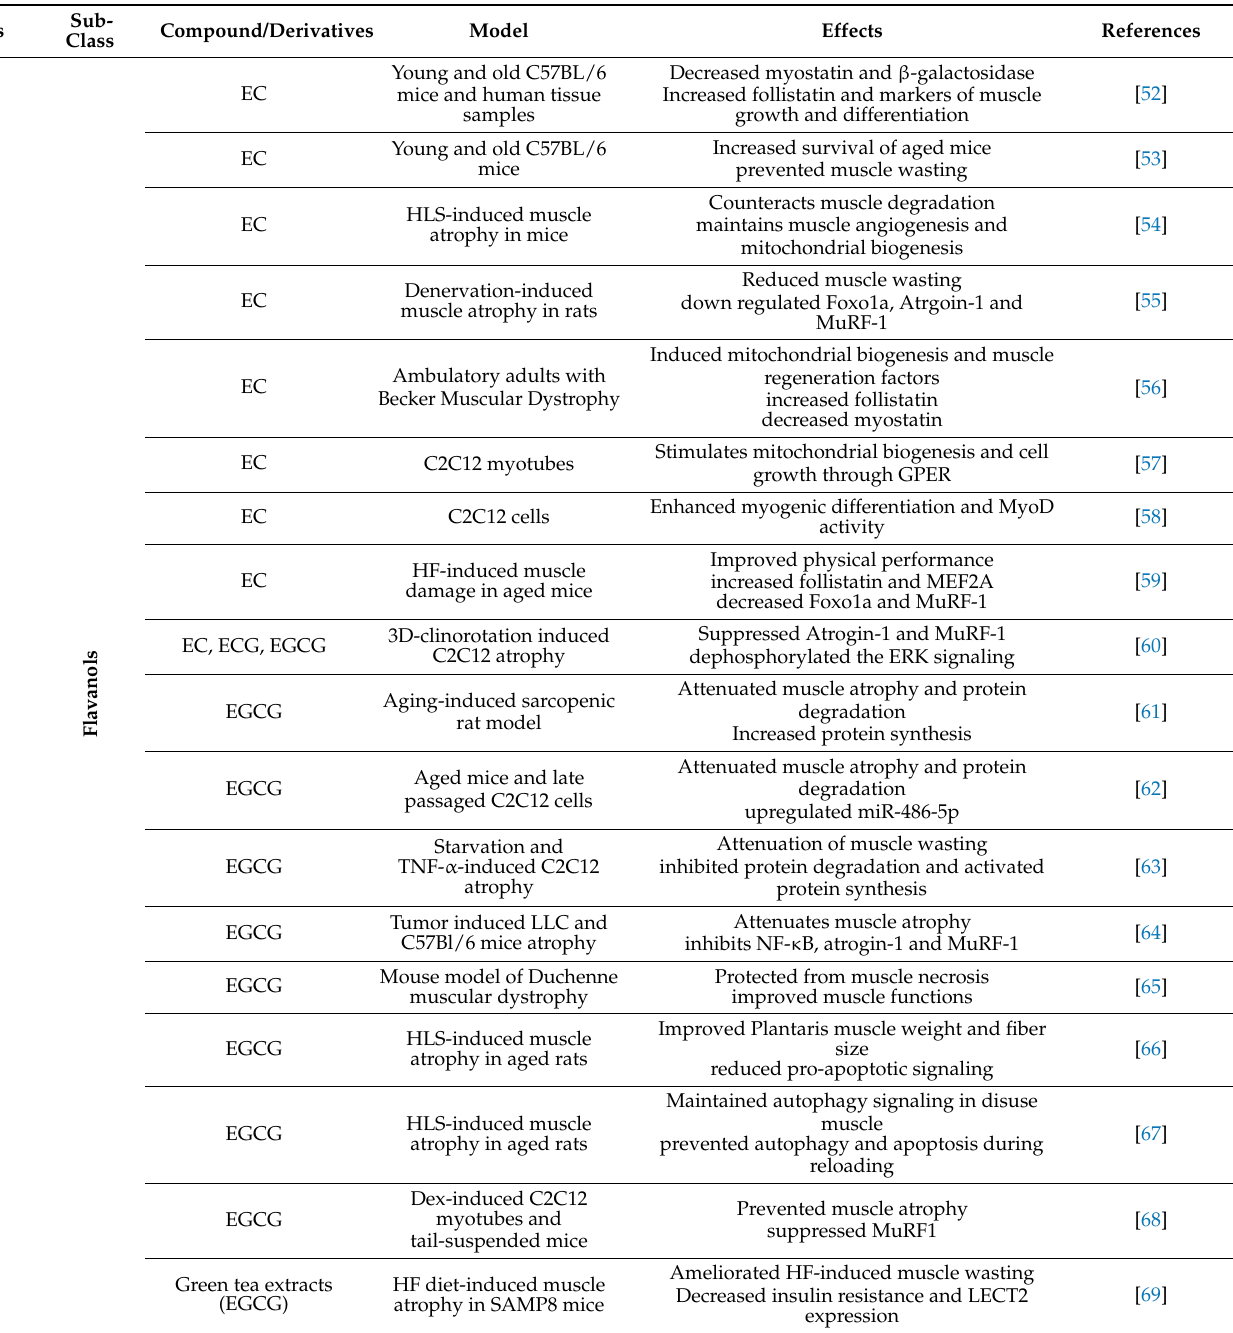
Table 2. Function of flavonoids and its derivatives in promotion of muscle health and prevention of muscle atrophy. 8-PN, 8-prenylnaringenin; Dex, dexamethasone; EGCG, epigallocatechin